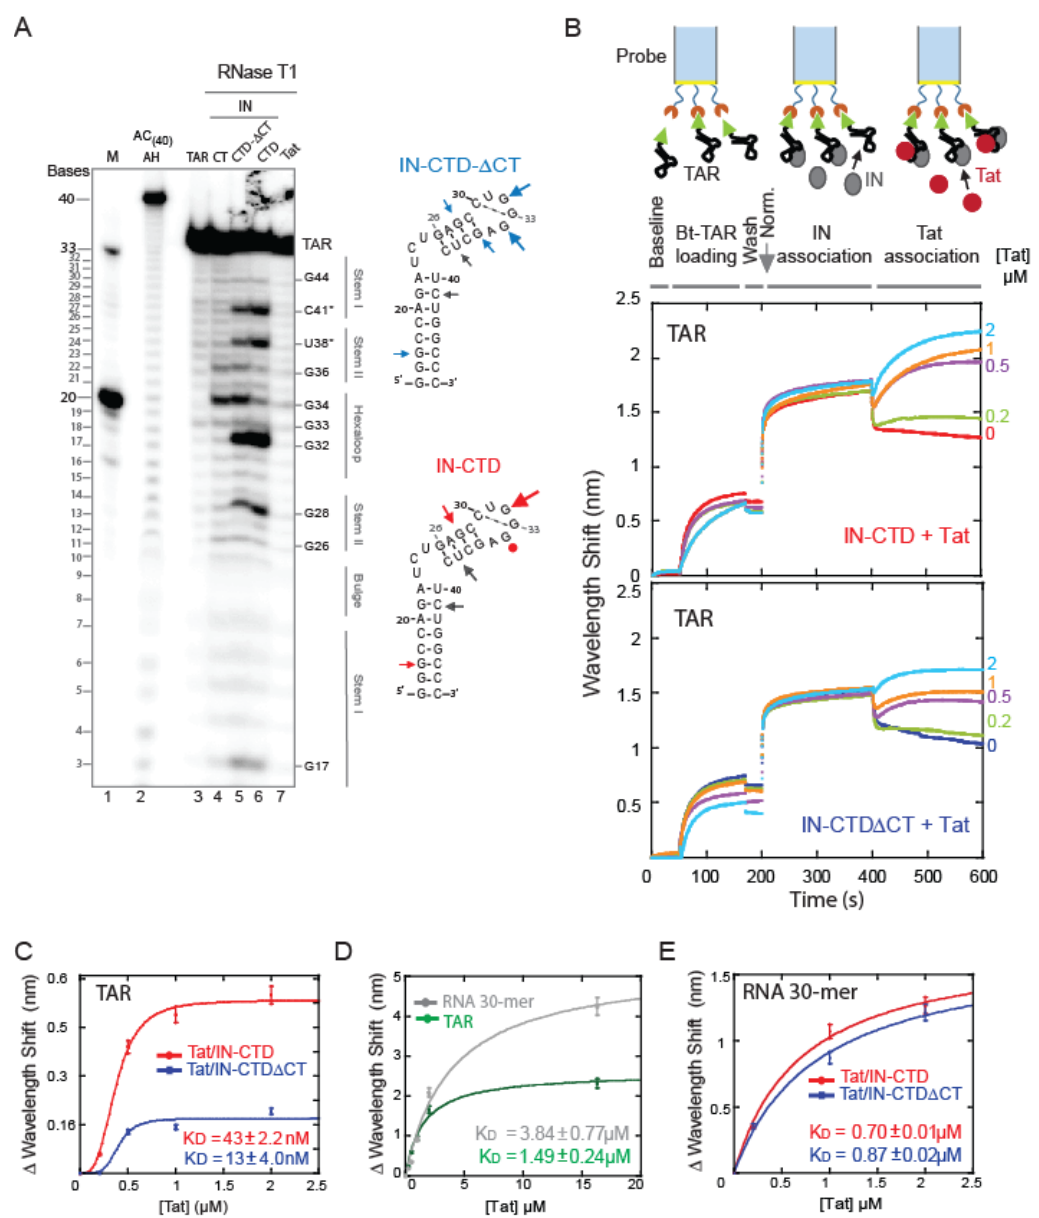
Figure 3. IN induces structural modifications of TAR, promoting Tat binding. ( A ) Probing the change in the secondary structure of TAR RNA complexed with different fragments of IN and Tat.